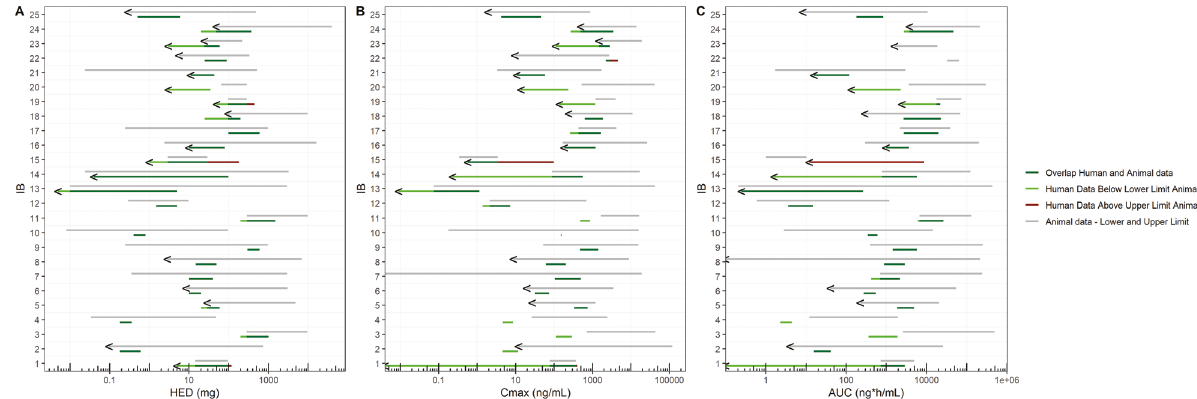
Fig. 4 Pharmacologically active dose ranges. A The overlap ranges for HED are depicted. B The overlap ranges for C max are depicted. C The overlap ranges for AUC are depicted. For both preclinical (animal) and clinical (human) studies the investigated ranges per pharmacokinetic parameter are depicted. The preclinical (animal) ranges are depicted in grey. The clinically (human) pharmacological active range that was below the range in which pharmacological activity was observed preclinically (animal) is depicted as light green. The clinically (human) pharmacological active range that was above the range in which pharmacological activity was observed preclinically (animal) is depicted as red. The overlap of preclinical and clinical pharmacological active dose ranges is depicted as dark green. < Means that the lowest dose tested already demonstrated an